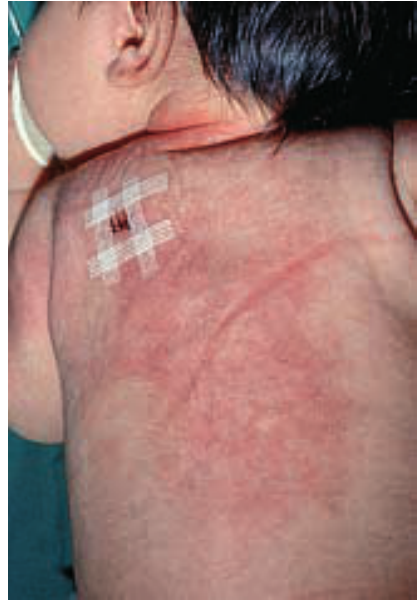
Rear view of an infant with subcutaneous fat necrosis showing large, firm, erythematous nodules and plaques over the back, neck and upper arms. Note the incision from a deep skin biopsy on the left